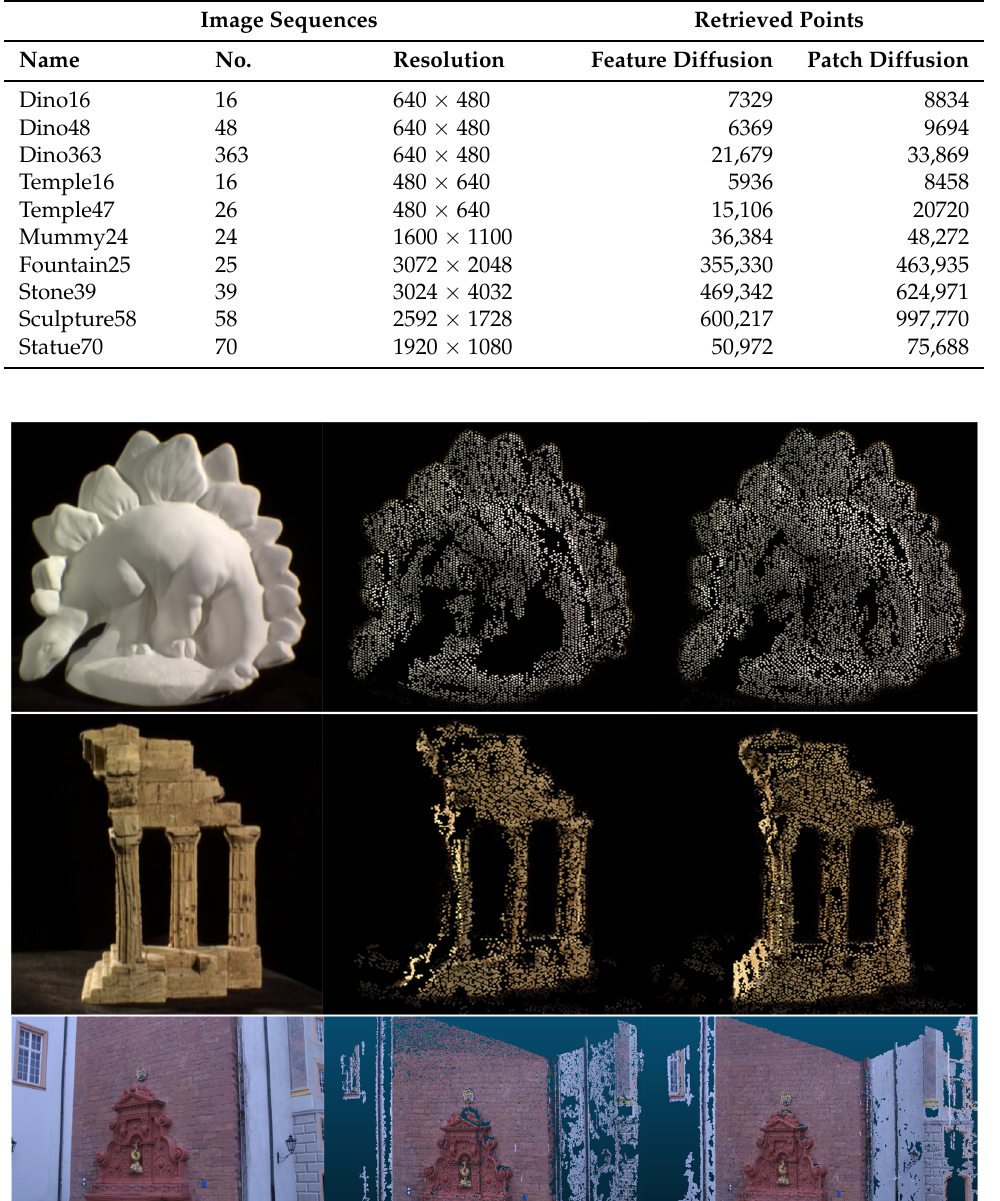
Table 1. Two phase results of the proposed algorithm on testing datasets.